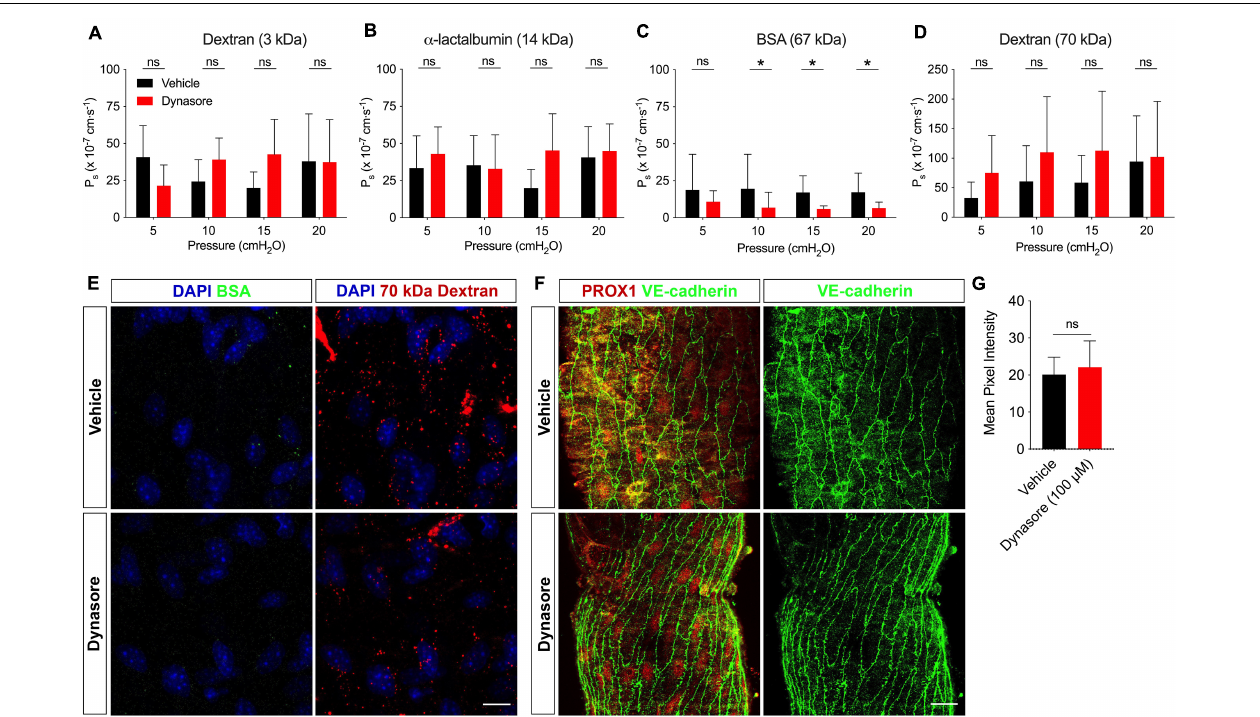
FIGURE 3 | BSA utilizes vesicular transport to cross the lymphatic barrier. P s of collecting lymphatic vessels to (A) 3 kDa dextran ( n = 7), (B) α -lactalbumin ( n = 5), (C) BSA ( n = 8), or (D) 70 kDa dextran ( n = 8) was determined first in the presence of vehicle (black bars), followed by dynasore (red bars), an inhibitor of vesicle formation. (E) Collecting lymphatic vessels treated with either vehicle of dynasore (100 µ M) and imaged immediately after perfusion of BSA-AF488 (green) and 70 kDa dextran (red). Vesicles containing BSA-AF488 and 70 kDa dextran-TR are visible in the endothelial layer. (F) Representative images of collecting lymphatic vessels stained for PROX1 (red) and VE-cadherin (green) after treatment with either vehicle or dynasore (100 µ M) and imaged by confocal microscopy. (G) Summary data of mean pixel intensity from n = 3 pairs of isolated, immunostained lymphatic vessels treated as in D (Student’s unpaired t -test; P = 0.71). All graphs show mean ± SD and each “ n ” refers to a different mouse. *, P < 0.05 by two-way ANOVA. Scale bar is 10 µ m in panel (E) and 20 µ m in panel (F) .